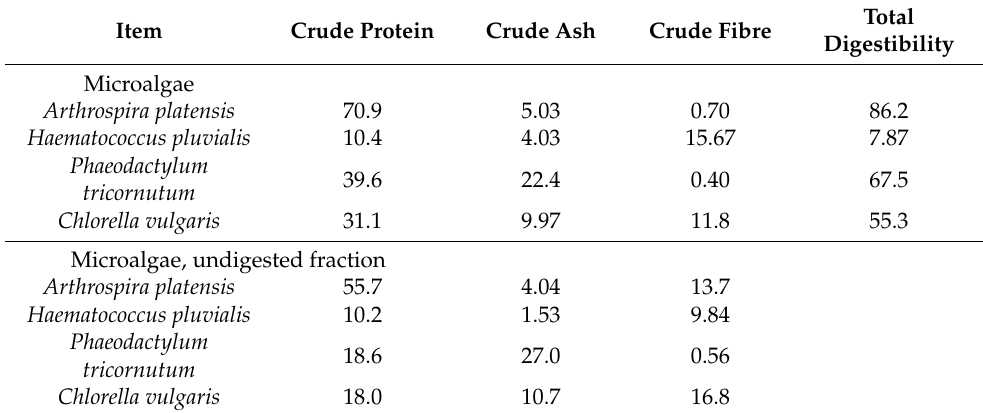
Total Digestibility